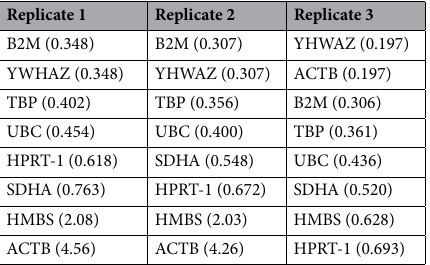
Table 1. Ranking of candidate reference genes in order of their average expression variation, decreasing from top to bottom. Average expression stability values (M) are shown between